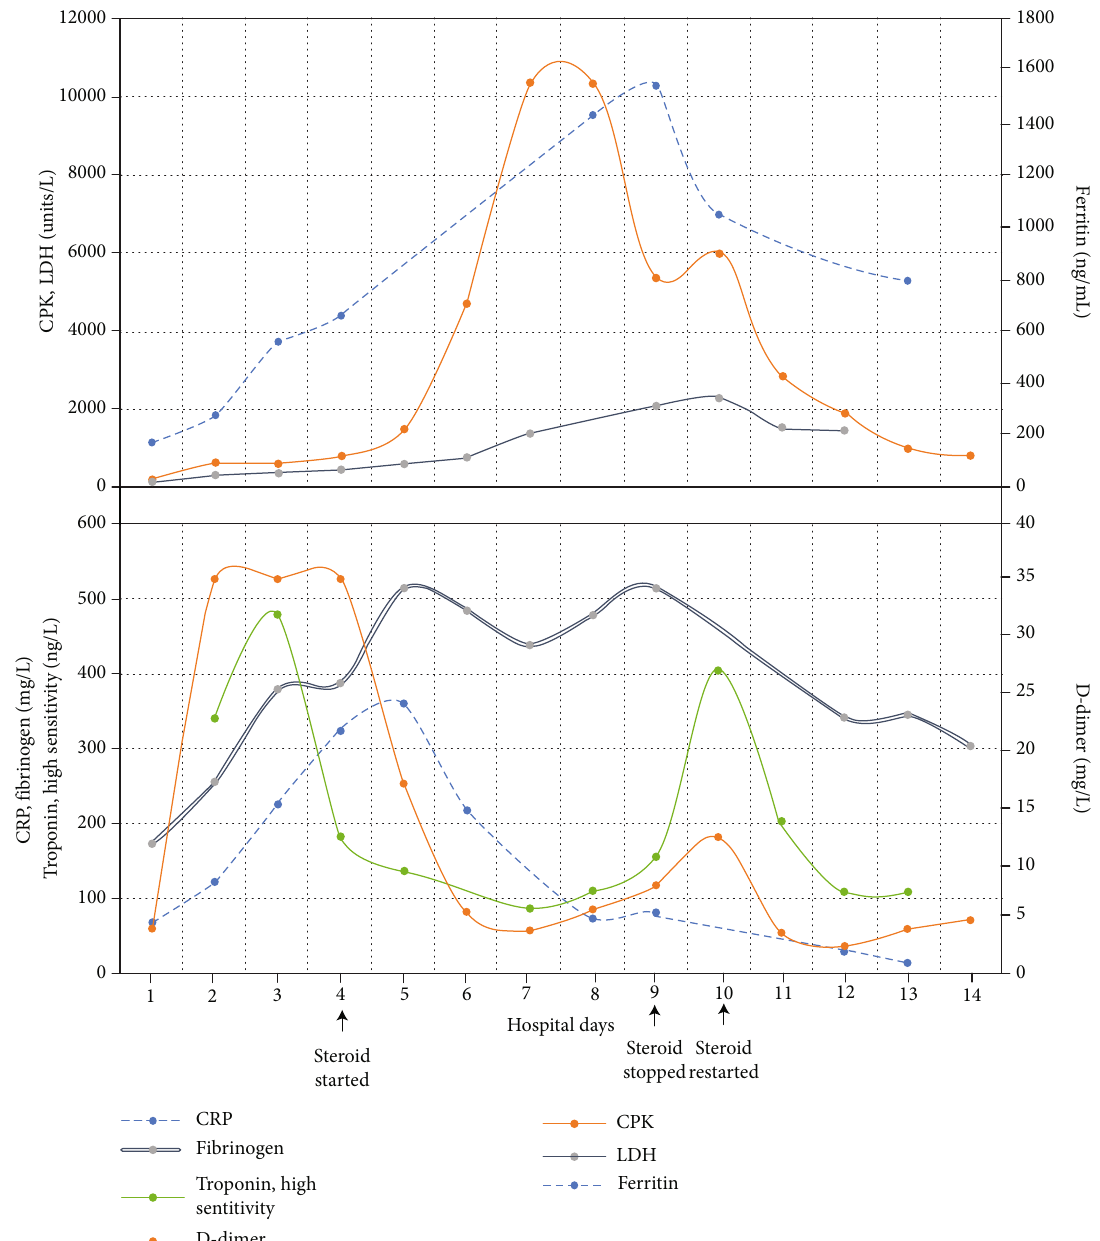
Figure 2: In fl ammatory markers over